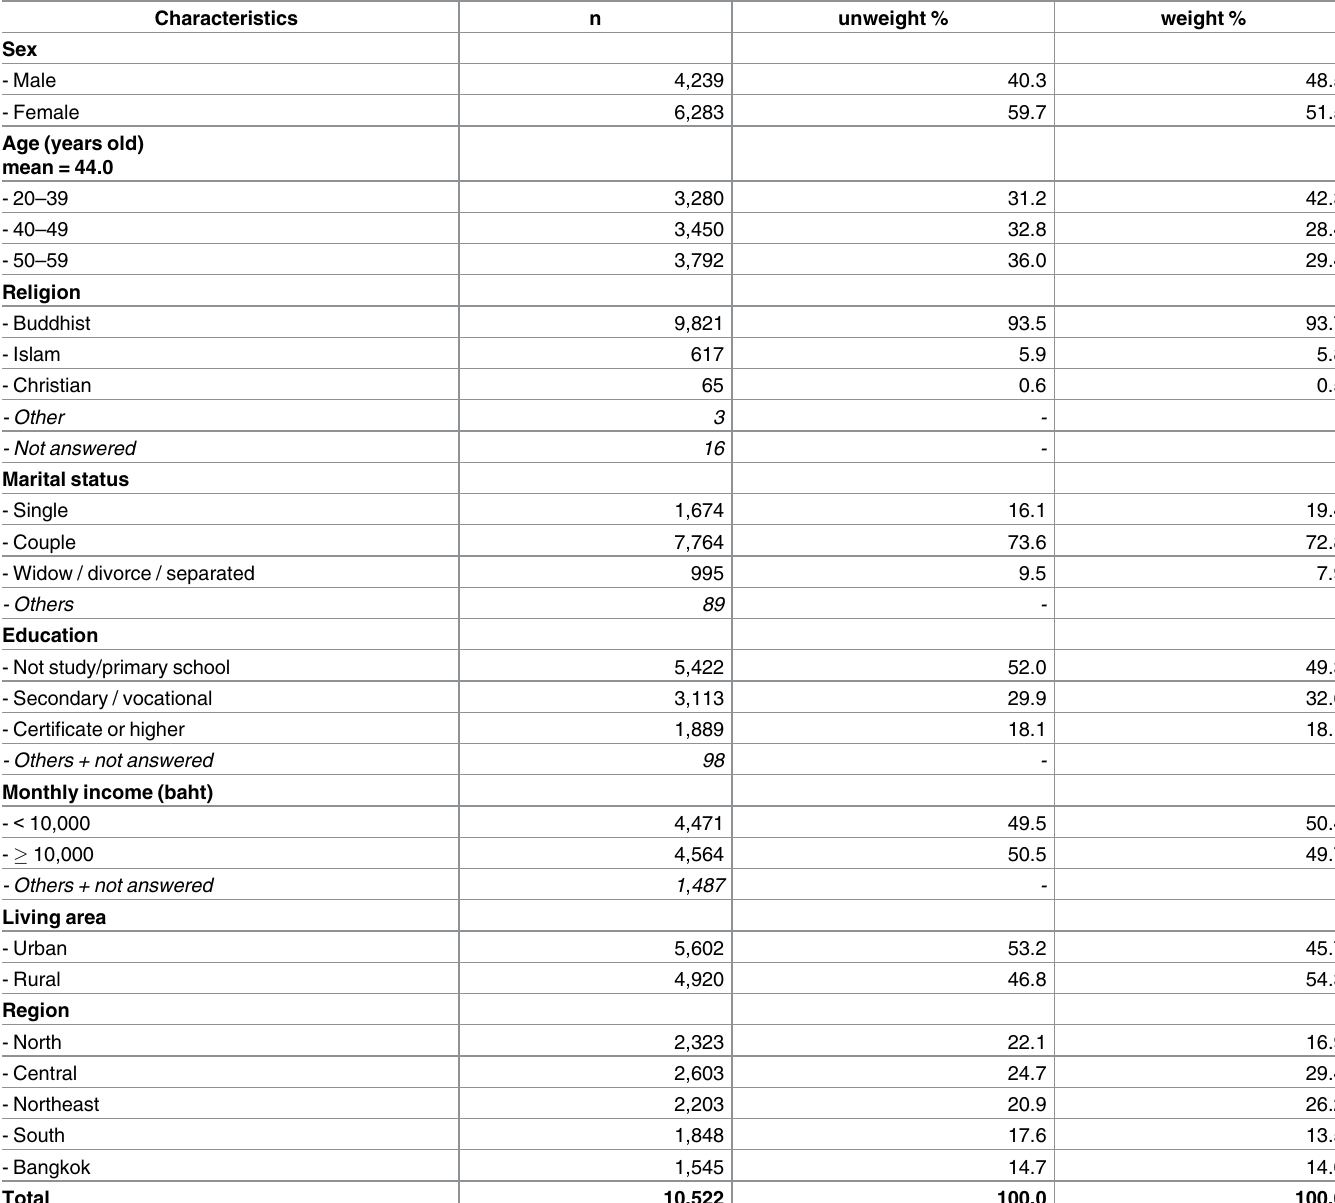
Table 2. Characteristics of the